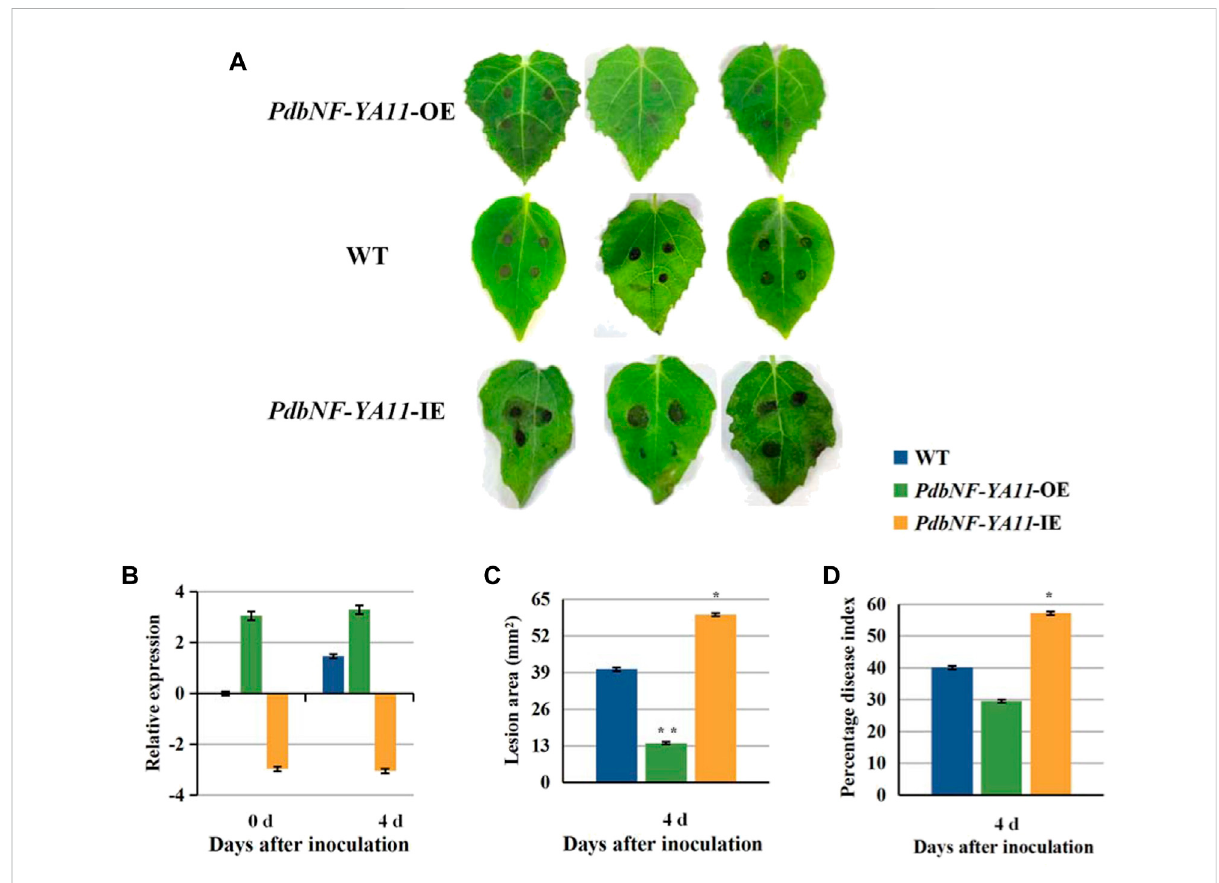
FIGURE 8 PdbNF-YA11 enhancesresistanceto A.alternata inpoplar. (A) LeavesofWTandtransgenicpoplarinoculatedwith A.alternata plugsfor4dpi. (B) Relative expression levels of PdbNF-YA11 during infection in WT and transgenic plants. (C) Lesion areas of leaves. (D) Percentage disease index at 4 dpi. The error bars represent the standard deviation of triplicate assays. Asterisks show signi fi cant differences between inoculated and noninoculated leaves (** p < 0.01 and * p <